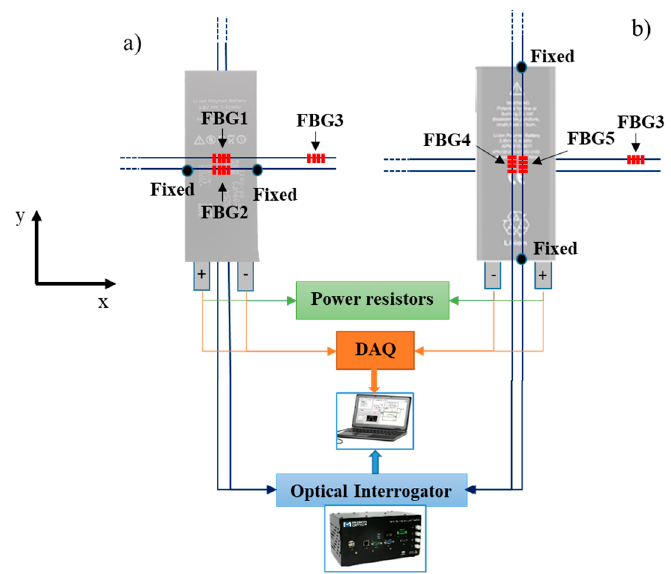
Figure 1. Experimental setup diagram of the temperature and bi-directional strain monitoring system of the battery: ( a ) down view; ( b ) top view.